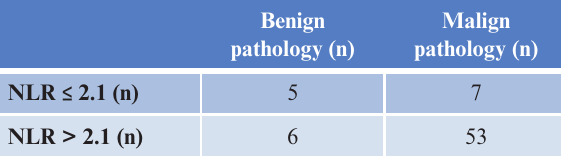
Table 4: Sensitivity and specificity of neutrophil-to- lymphocyte ratio in predicting the malign pathology after renal mass